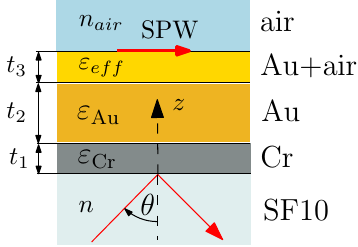
Figure 3. An SPR structure under